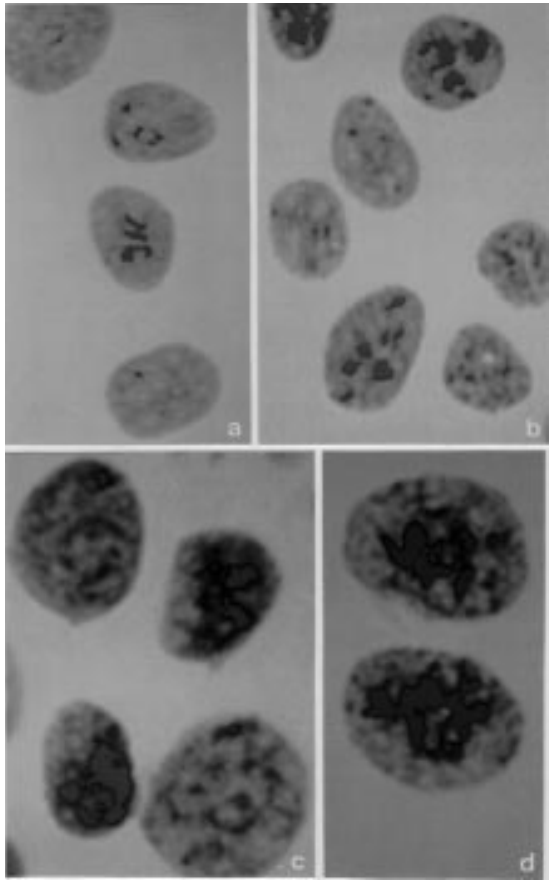
Fig. 7. Comparison of the distribution of AAR (average absorption ratio, see text) vs. Sc% (condensed chromatin area) values